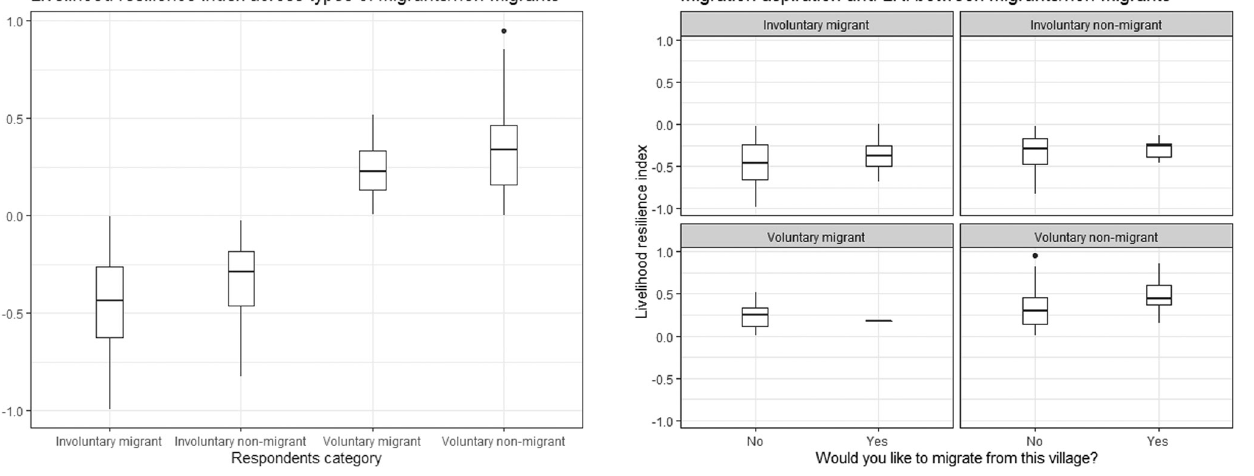
Fig. 6 Migrants and Non-Migrants with their LRI and future migration aspiration. Source: Field survey 2020.